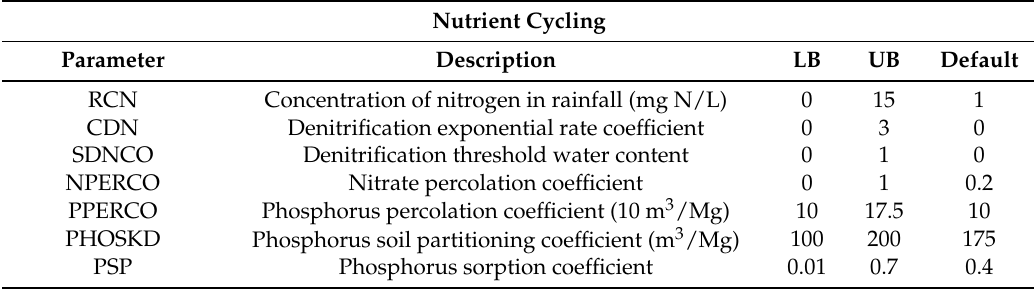
Table A3. Adjustable SWAT parameters for nutrient cycling functions.